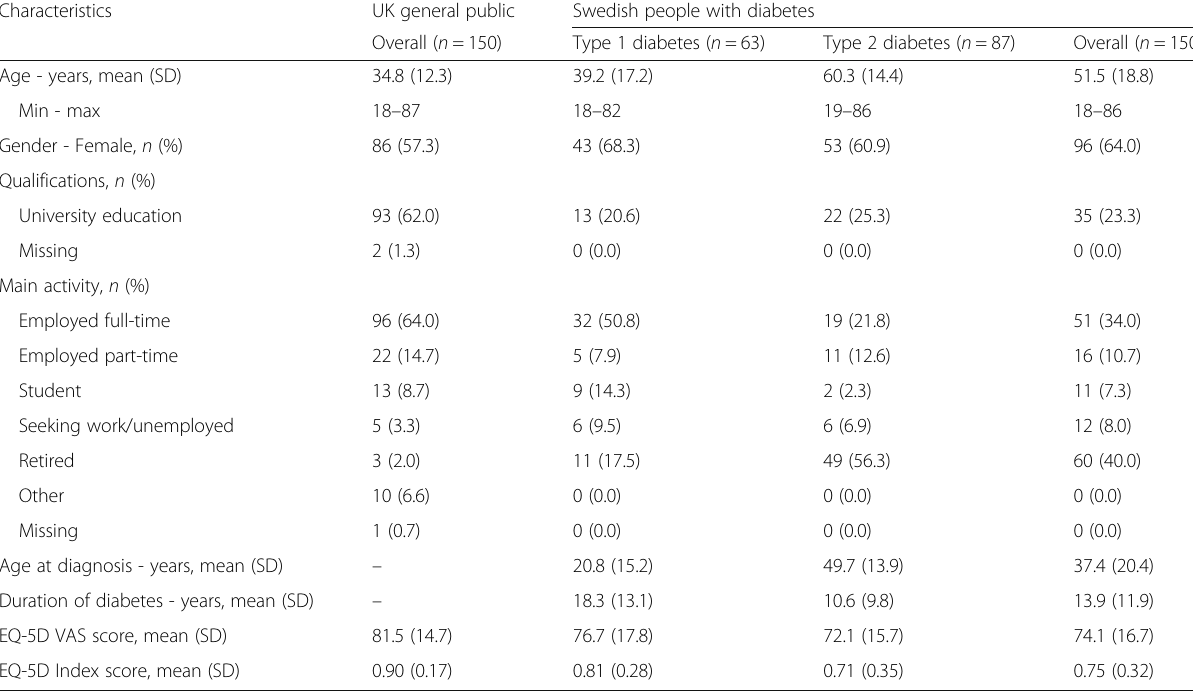
Table 2 Participant characteristics and EQ-5D visual analogue scale (VAS) and index scores by country and diabetes type (UK general public n = 150; Swedish people with diabetes n = 150)